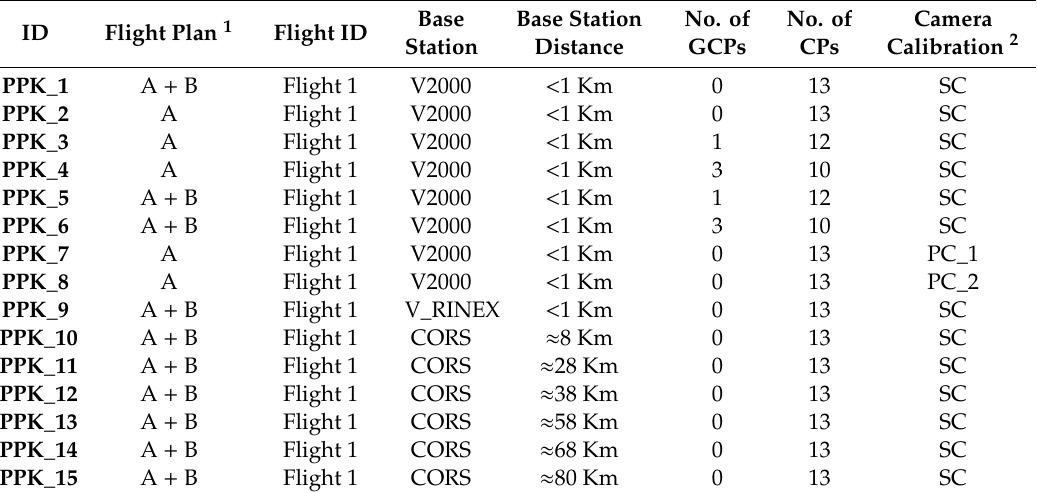
Table 8. PPK processing strategies for Flight